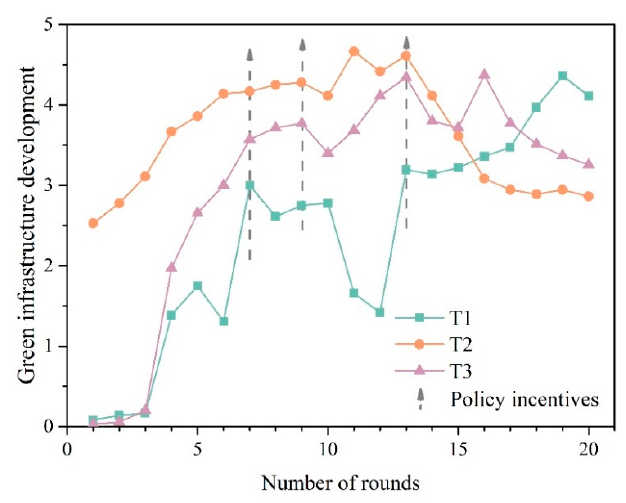
Figure 5. Players’ performance in Green Infrastructure Development with policy incentives.